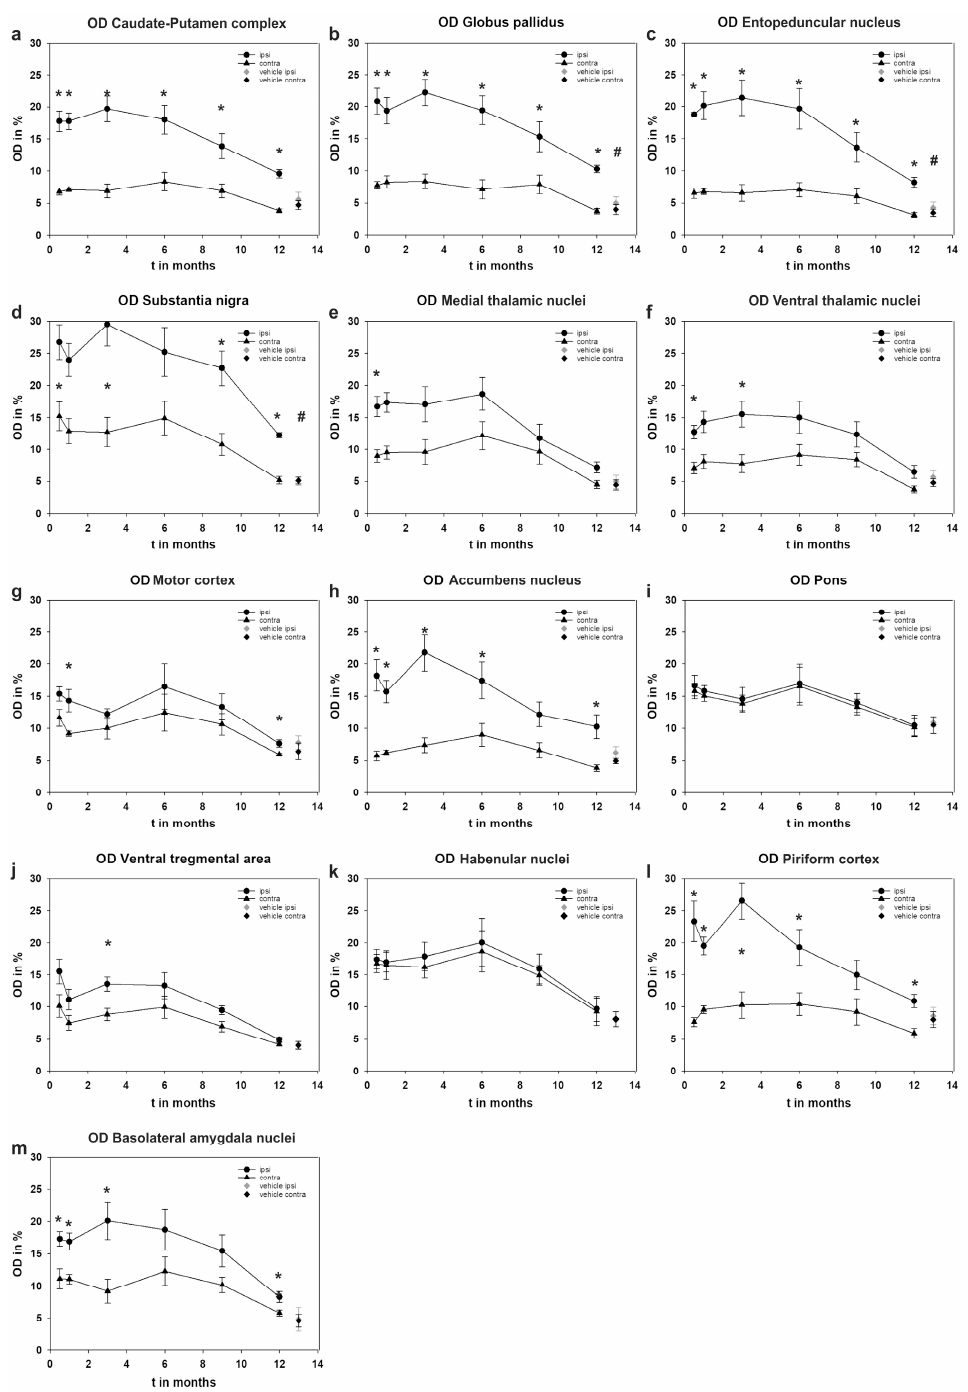
Figure 5. Time courses of areal-specific mean optical densities (OD) of cleaved SNAP-25. The x -axis shows the survival time after BoNT-A, and the y -axis shows the OD in %. The mean OD of the treated side (black circles) and the untreated sides (black triangles) are plotted ± the standard error of the mean. For comparison, the OD of the sham-injected hemispheres 12 months post-injection are marked with gray diamonds, and the values of the respective contralateral sides with a black diamond. For clarity, these values were plotted at month 13. At each time point, the OD of the ipsilateral side and contralateral sides were compared using the Mann–Whitney U-test. Significant differences between the hemispheres are marked with asterisks (*). If there were significant differences between the right (treated) hemisphere and the right hemisphere of sham animals at 12 months after treatment, a diamond (#) is shown above the values of the sham animals. In subfigures ( a–m ), one can see the development of mean OD for the following brain structures on both the contralateral and ipsilateral sides to the injection side: ( a ) Caudate-Putamen complex, ( b ) Globus